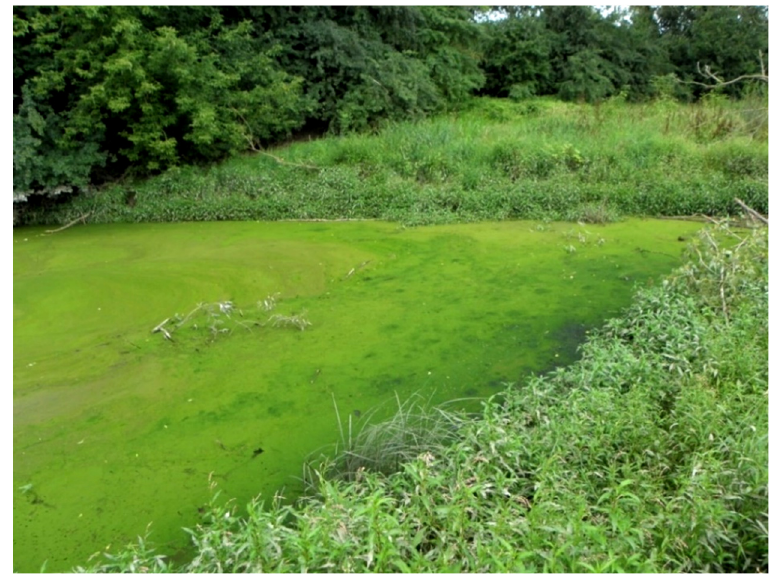
Figure 5. Reservoir number 8, summer.